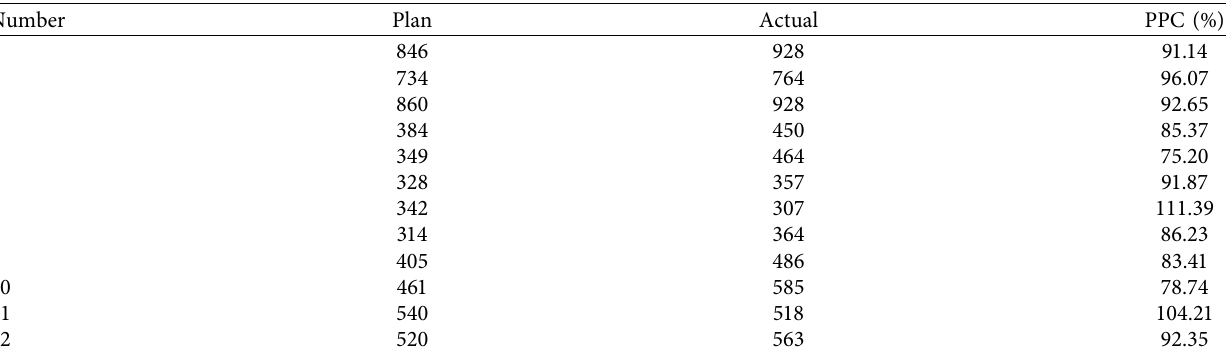
Table 2: Summary of the completion of the plan.